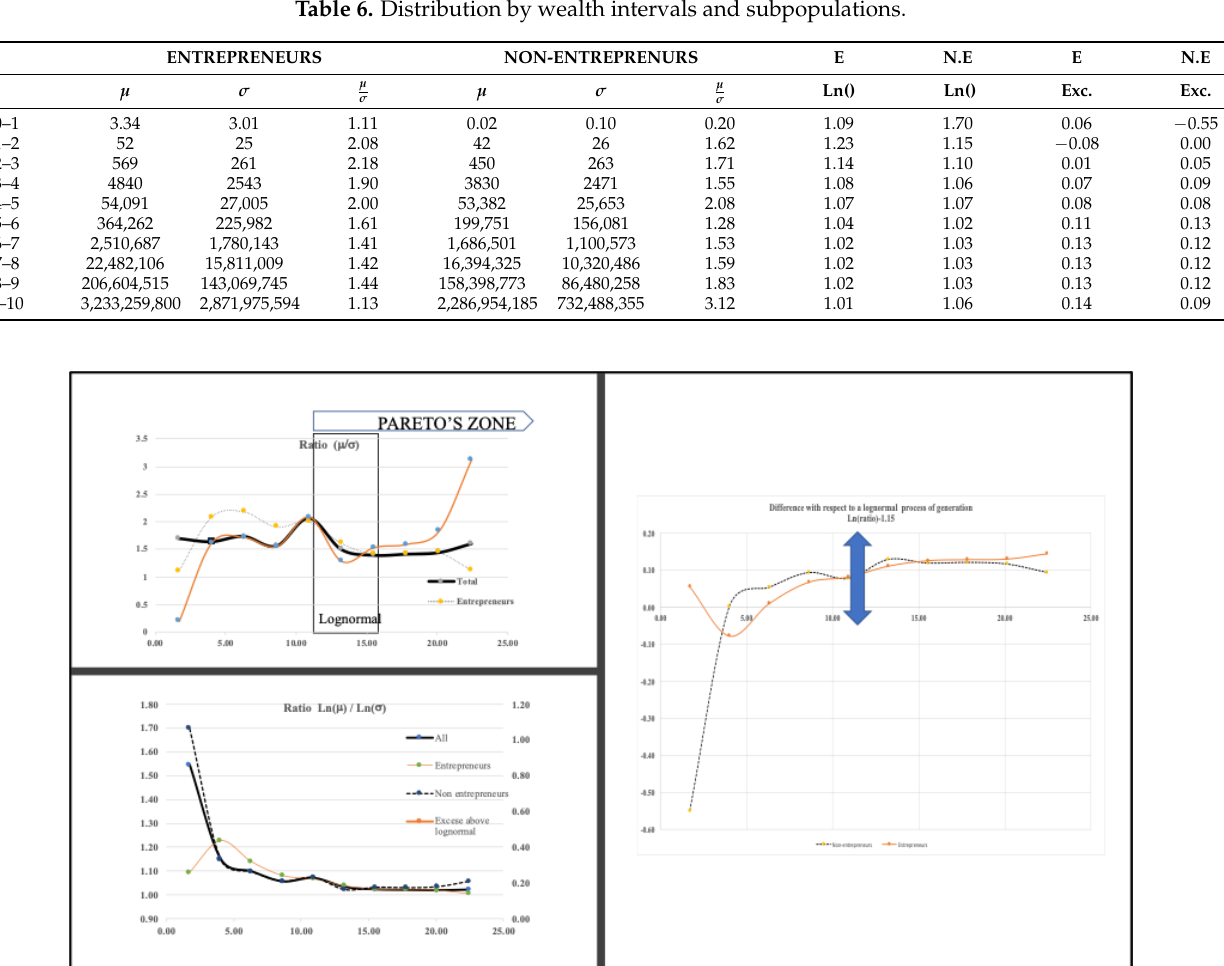
Figure 11. Analysis of the subpopulations in ranges of order